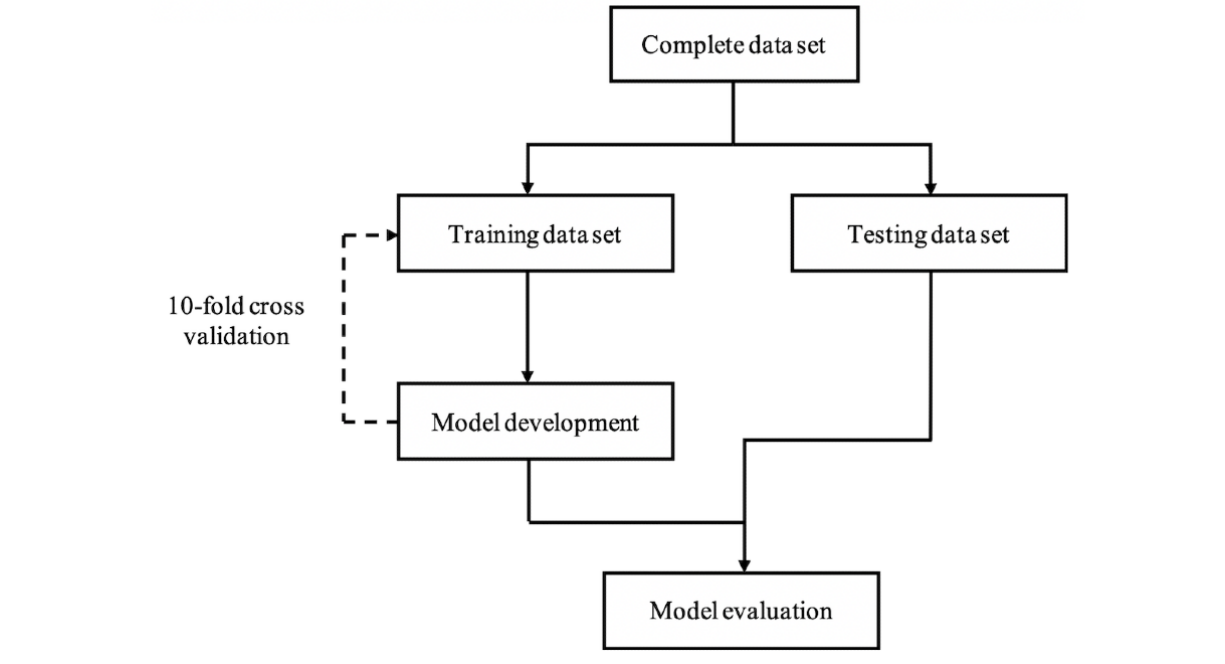
Figure 2. Model development and testing